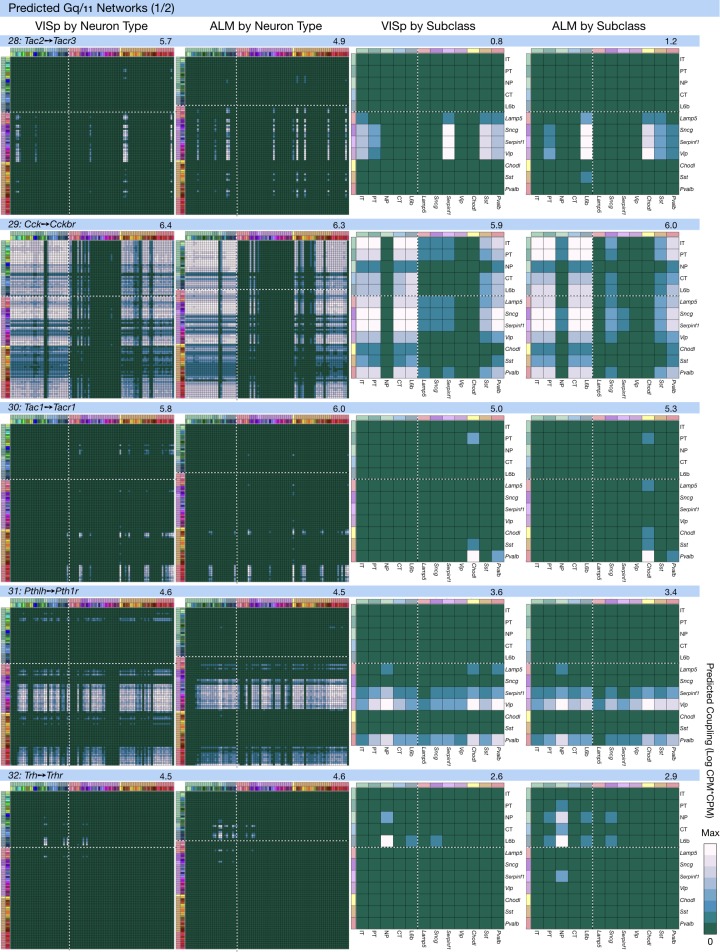
Neurotaxonomic coupling predictions for cognate NPP/NP-GPCR pairs #28-#32.Predictions for all 37 cognate pairs in both VISp and ALM cortical areas are grouped and color-coded according to Gα signal transduction family. All predictions were generated as described in connection with Figure 6 and represented as in Figure 6C–E for neuron types and in 6F for subclasses. Numbers at upper right indicate the maximum value to which each plot was normalized, in units of CPM*CPM.